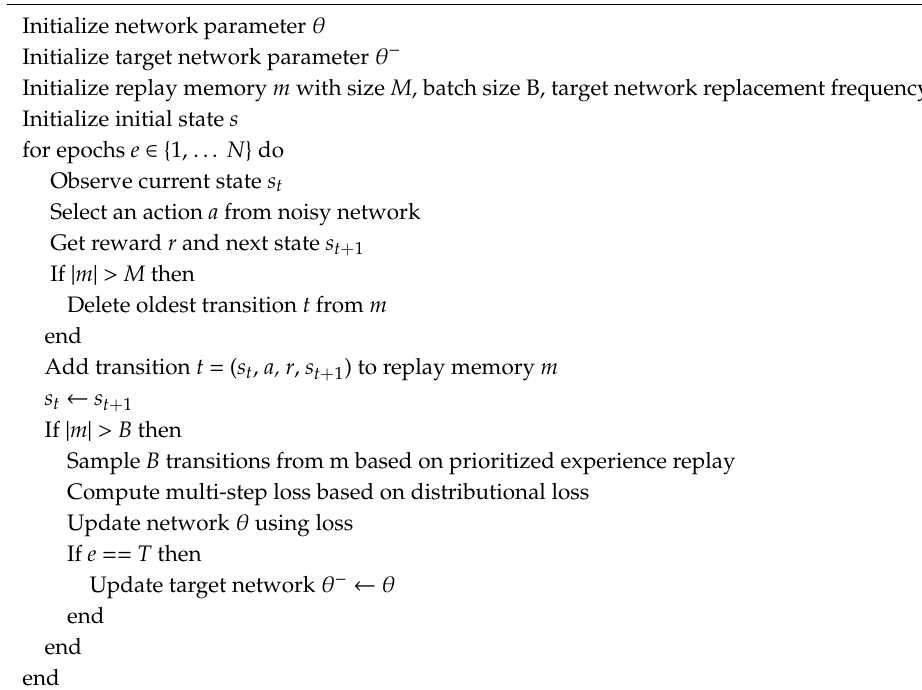
Algorithm 1. Cooperative tra ffi c signal